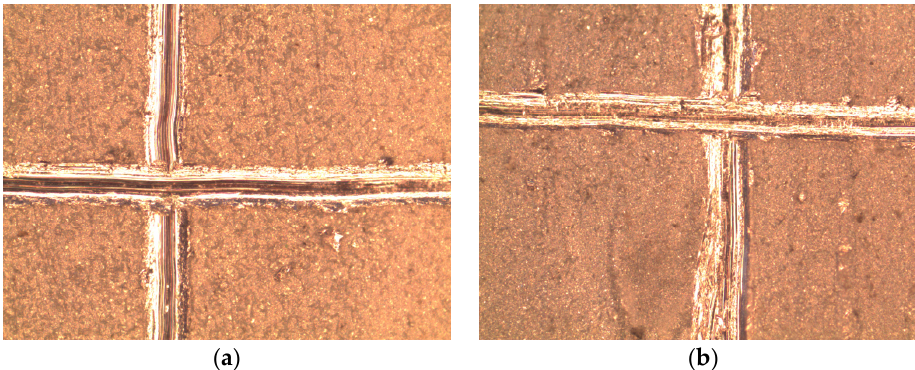
Figure 4. The scratches on the surface of the nickel–chromium alloy ( a ) and the CEC nickel–chromium–GO ( b ) deposited at cathodic current density i C = 10 A/dm 2 . Magnification × 100.